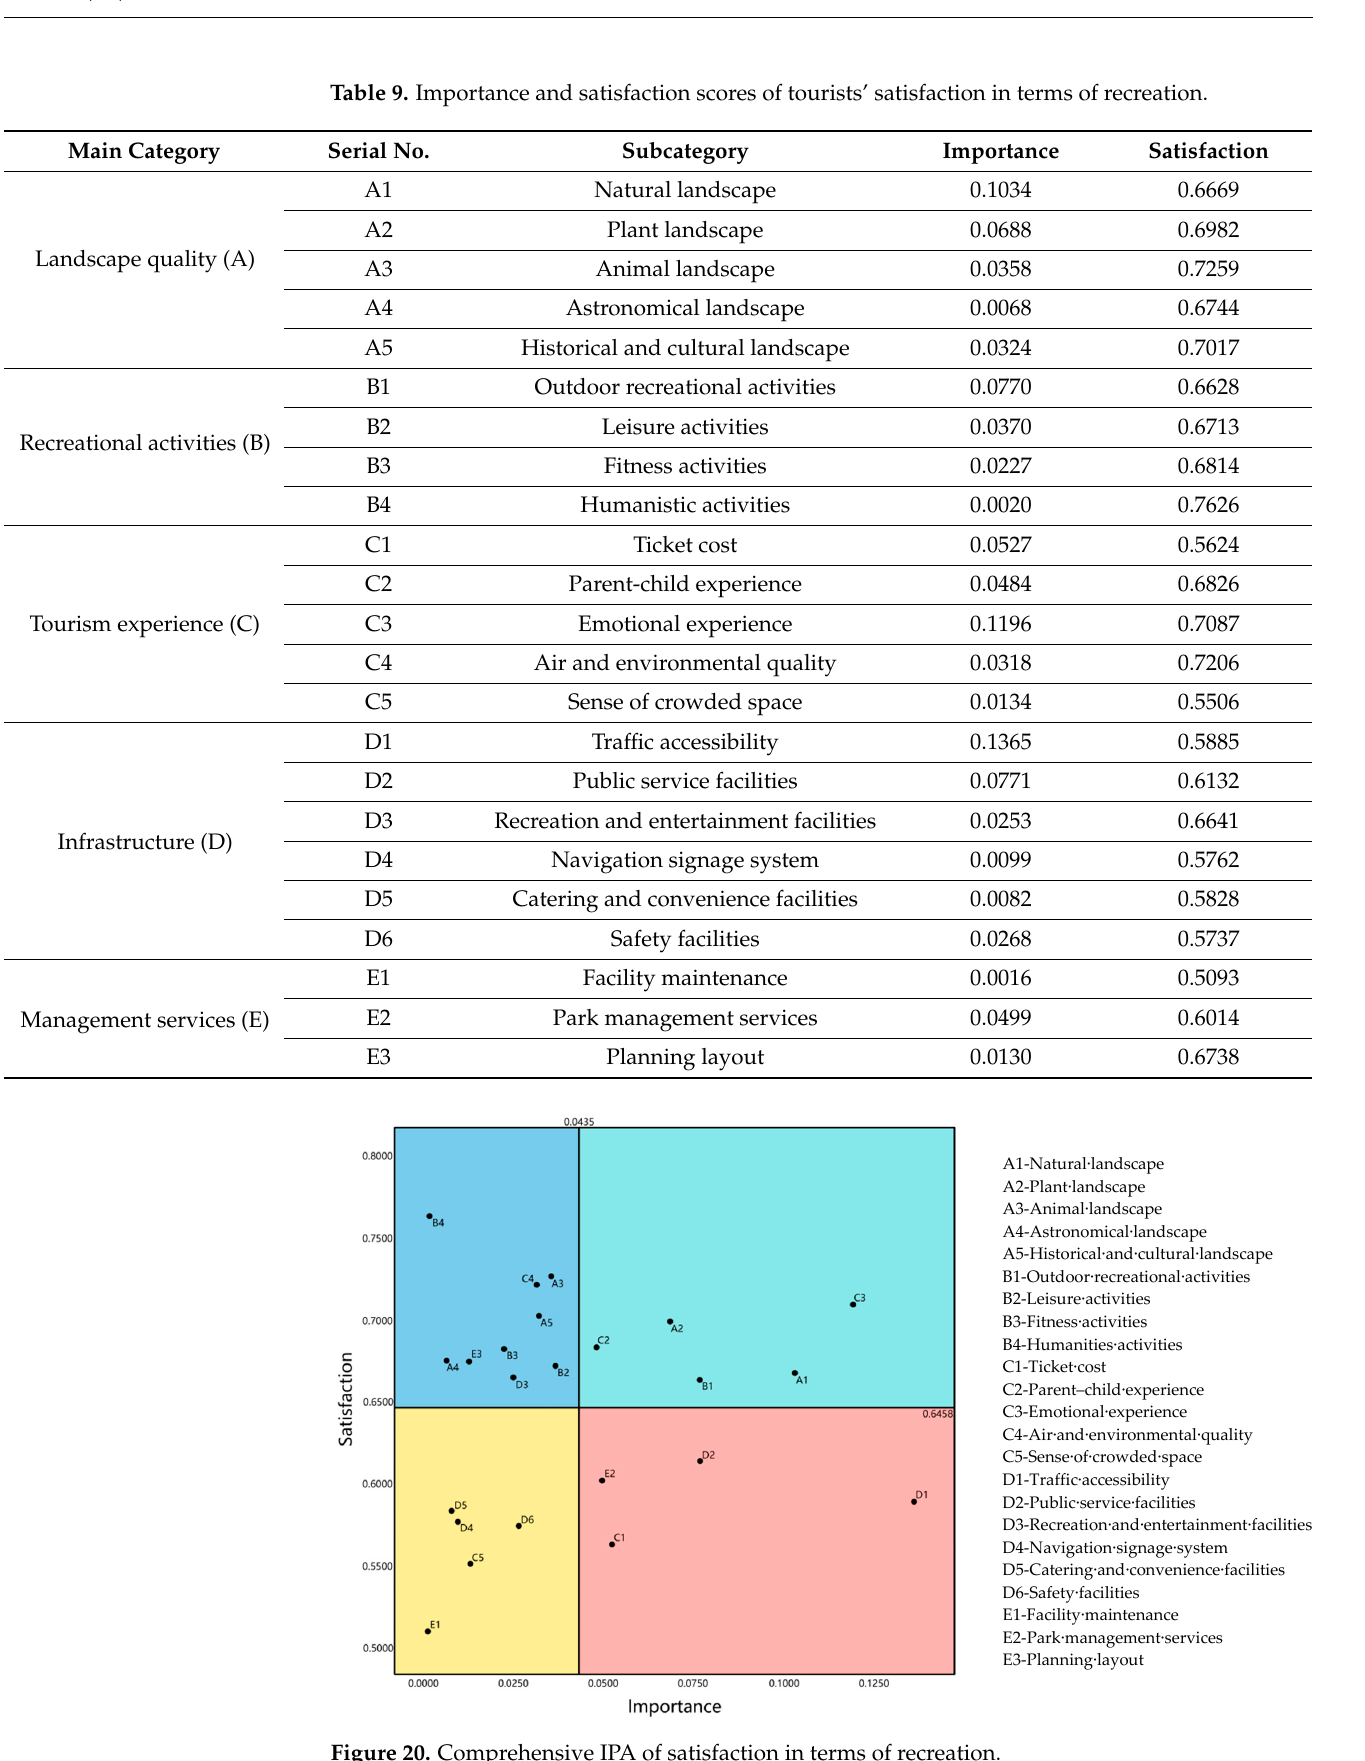
Figure 20. Comprehensive IPA of satisfaction in terms of recreation. The IPA (Table 10, Figure 21) of mountain landscapes in different mountain ranges showed that tourists were more satisfied with the overall recreation offered by the moun- tain landscapes in the Taihang Mountains than those offered by the Yan Mountains. Tour-